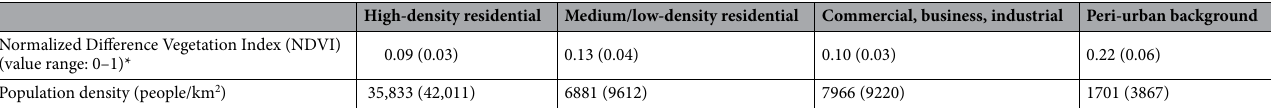
Table 3. Population density and vegetation at measurement sites. Data are summarized as means and standard deviations within land use areas. *To capture vegetation in the area surrounding each site, we created a 200 m radius buffer around the site and calculated the average NDVI within it. NDVI can be a negative value, which would indicate water, though at all of our measurement sites, NDVI levels were positive between 0 and +